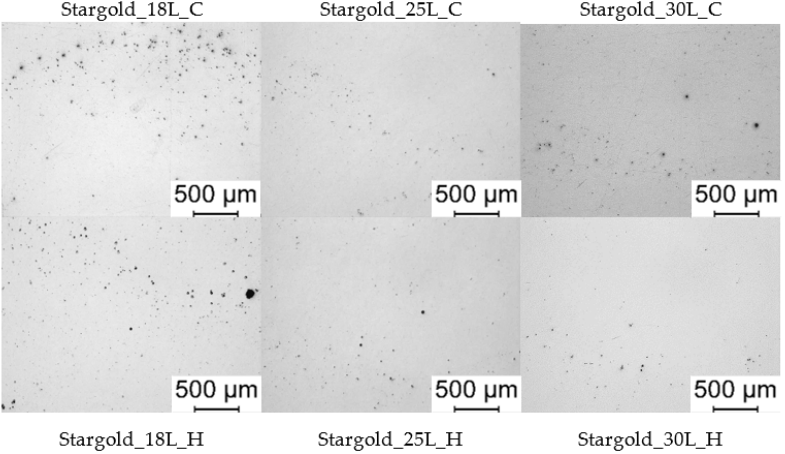
Figure 10. Porosity in AA5356 WAAM walls built with Stargold ® shielding gas. For the lowest shield gas flow rates (Figure 11), high dimensioned pores tended to be aligned and concentrated in the interlayer bands with smaller pores distributed randomly